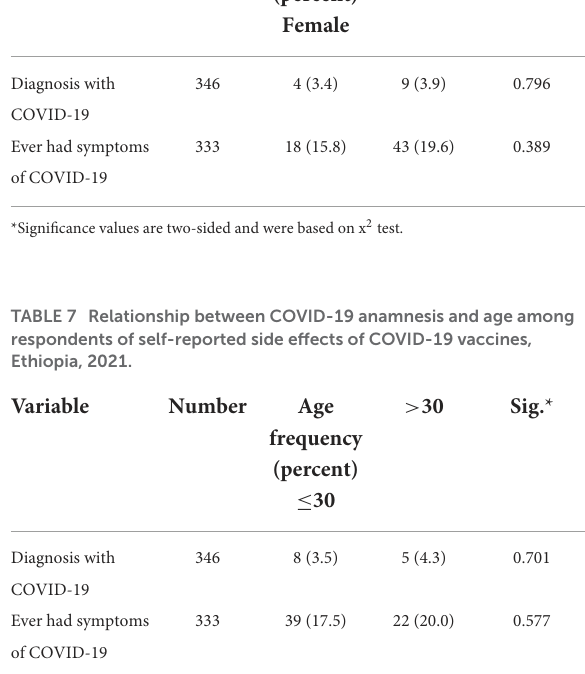
TABLE 10 Systemic side effects of COVID-19 vaccines among healthcare workers in Ethiopia,